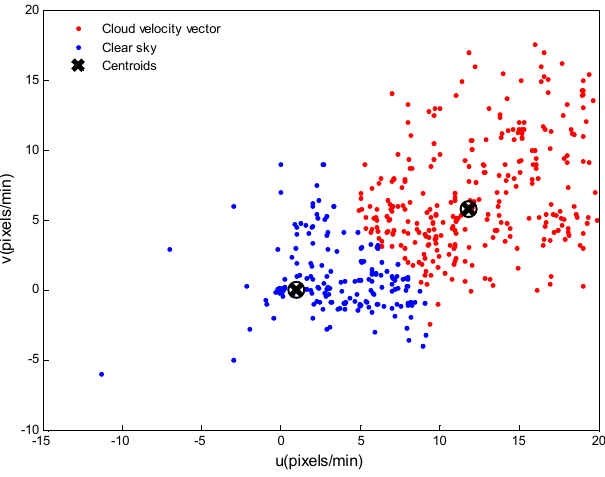
Figure 7. Determination of representative velocity vector.